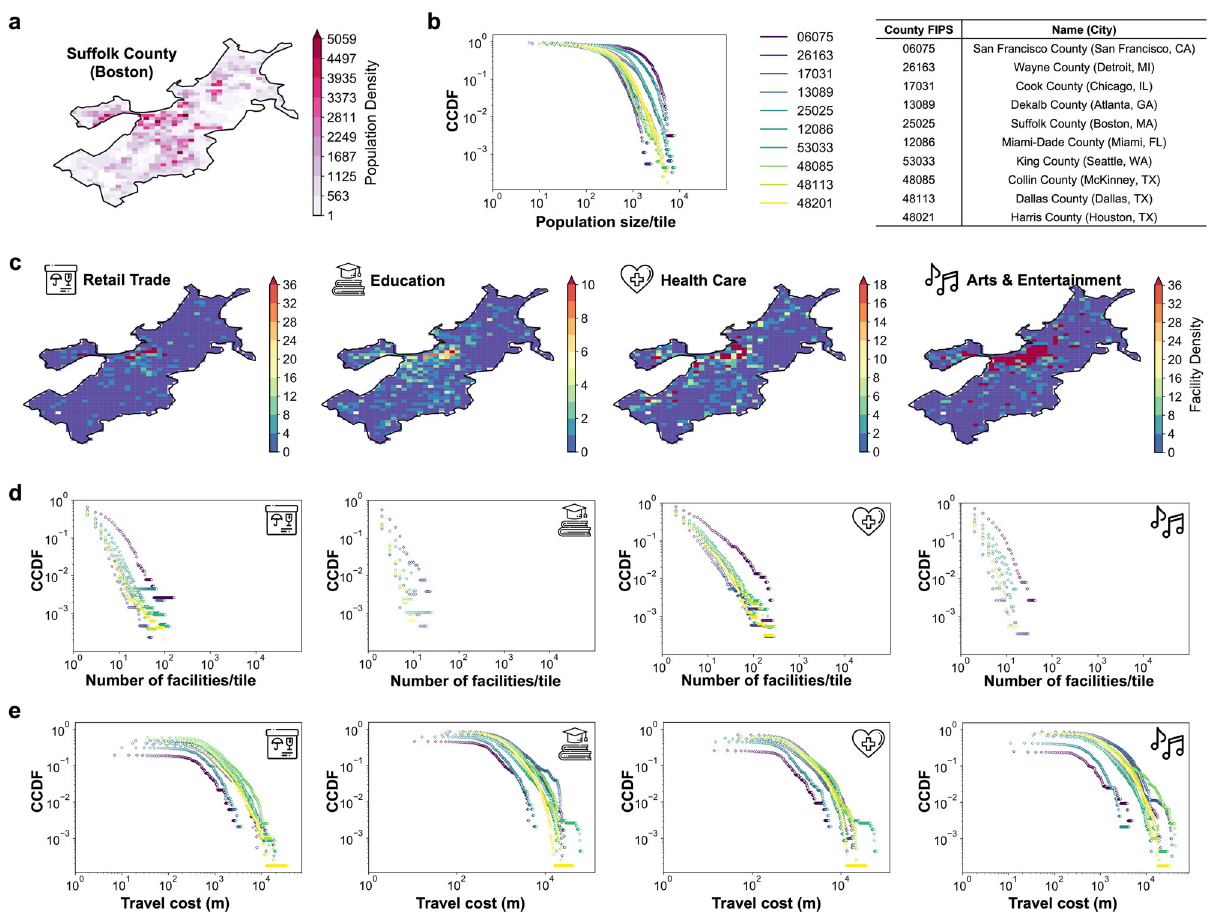
Fig. 2 Patterns of the existing population and facility distributions. a Population density in the grid map of Suffolk County (Boston). The population distributions in other counties are provided in Supplementary Fig. 7. b the complementary cumulative density function (CCDF) of population density for ten metropolitan counties. The counties are labeled by FIPS code, and the names of the counties are provided in the table next to the plot. c The density of four types of facilities, as examples, in the grid map of Suffolk County. The plots for other counties and facilities are provided in Supplementary Figs. 8, 9. d CCDF of facility density for ten metropolitan counties for four exemplary types of facilities; e CCDF of travel cost from each residential grid cell (tile) to their nearest facility grid cell. The people living in the same grid cells have the same travel cost in accessing the same facility grid